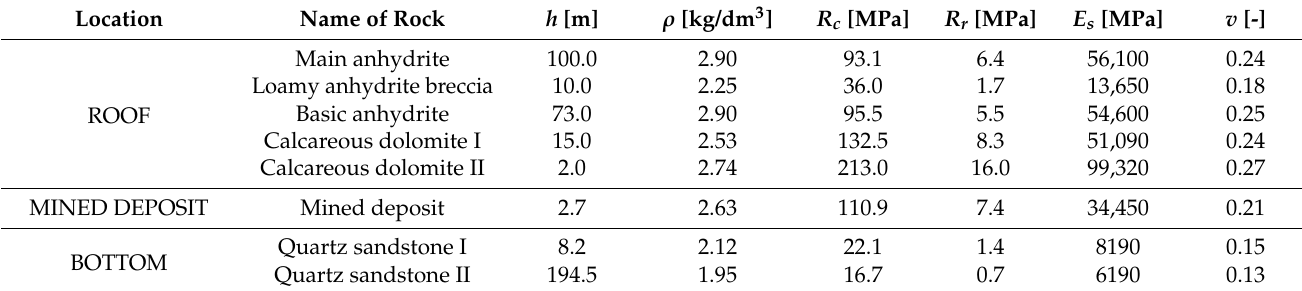
Table 1. Averaged geomechanical parameters of rock.